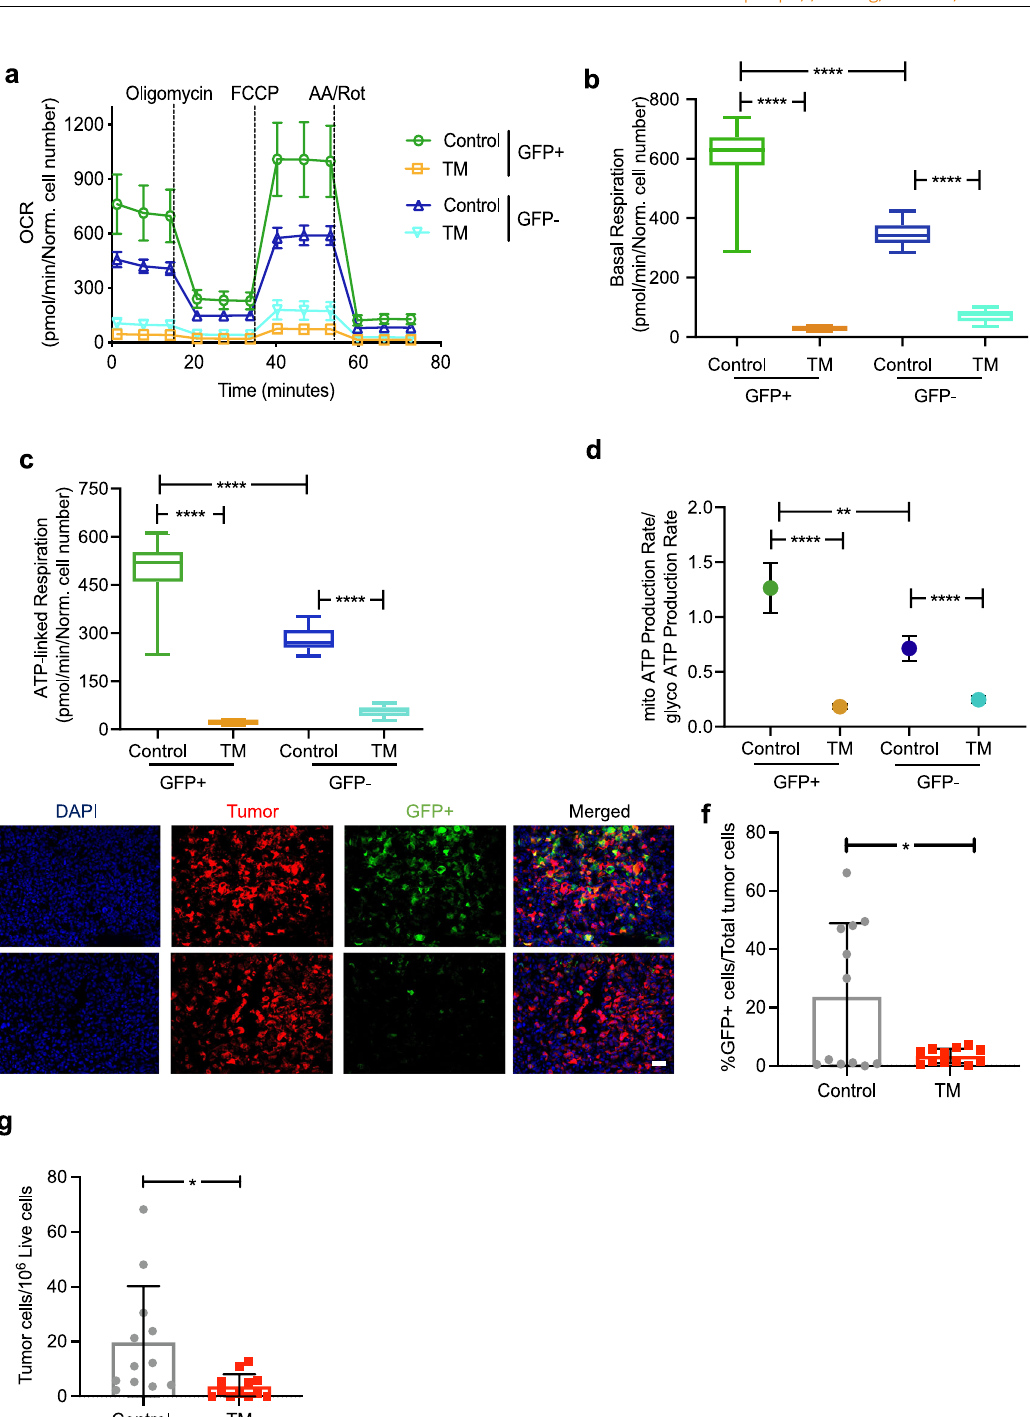
Fig. 4 Copper depletion disrupts mitochondrial respiration in SOX2/OCT4 + metastatic cells. a Impact of TM (0.5 µ M) on oxygen consumption rate of sorted GFP + and GFP − ML1 cells as measured by Seahorse assay ( n = 8/group). Quanti fi cation of basal respiration ( b ) and ATP-linked respiration ( c ) in GFP + vs. GFP- ML1 cells with and without TM (0.5 µ M). Signi fi cance was calculated using one-way ANOVA with Tukey post-test for comparing multiple groups. Center lines of box plots denote median values, top whiskers denote maxima and bottom whiskers minima. d Ratio of mitochondrial to glycolytic ATP production rate in GFP + vs. GFP − ML1 cells, measured by Seahorse ATP production rate assay ( n = 8/group). Signi fi cance was calculated using one- way ANOVA with Tukey post-test for comparing multiple groups. Representative data of two independent experiments are depicted. e Representative IF microscopy images from control and TM-treated (0.7 mg/day) primary LM2 tumors in the mammary gland ( n = 5/group). Scale bar, 20 µ M. f Flow cytometry analysis showing the percentage of GFP + cells in primary tumors in the LM2 model ( n = 12/group) of total mCherry + tumor cells. Analysis was performed by unpaired two-sided t -test. p -value = 0.0111. g Disseminated tumor cells in early lungs of control and TM (0.7 mg/day) treated LM2 cohorts. Analysis was performed by unpaired two-sided t -test. p -value = 0.0150. Representative data of two independent experiments are depicted. Results are expressed as mean ± SD. Results are expressed as mean ± SD. ** p < 0.01, **** p <